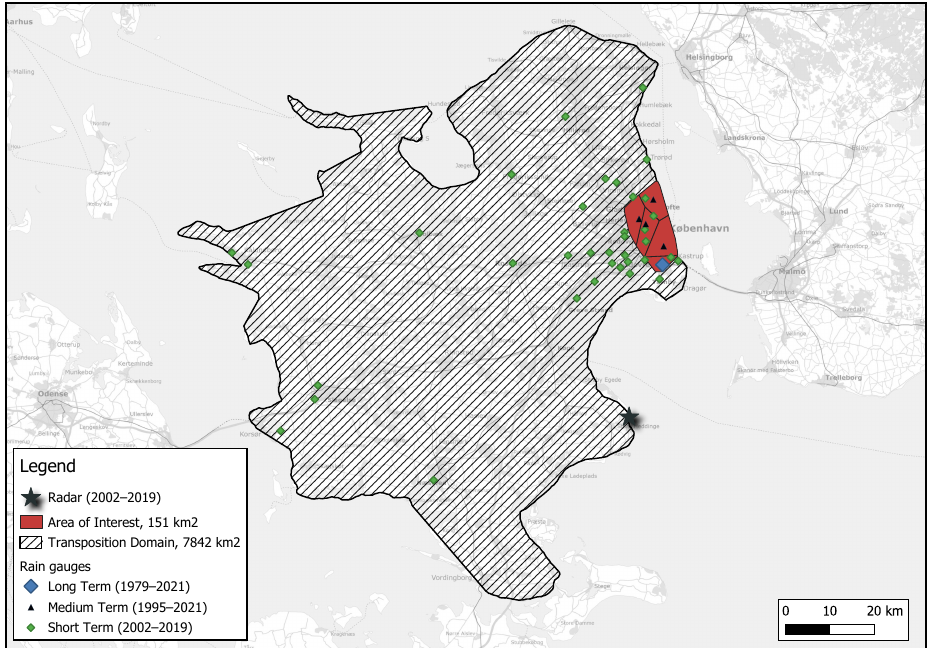
Figure 1. Island of Zealand: the study area for the present study. The shaded area represents the transposition domain used for the SST method, as presented in Section 3.1. All rain gauges used in the study are shown and labeled with the length of the observation period. The red area encapsulates the city of Copenhagen, which serves as the area of interest for the study. The division in the red-shaded area is a Voronoi polygon which is used to create area-weighted rainfall